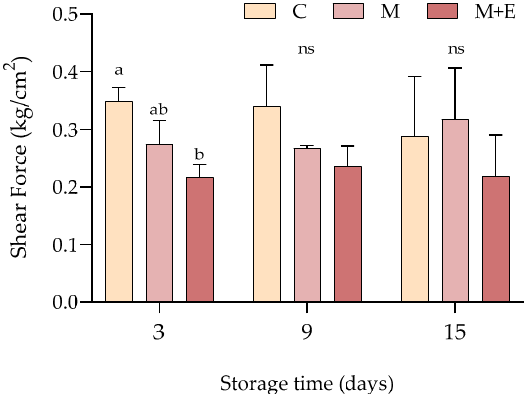
Figure 5. Average shear force values (kg/cm 2 ) of non-marinated (C), marinated (M) and marinated with essential oils (M + E) pork loin slices at 3, 9 and 15 days of refrigerated storage. Data represent means ± SD. a, b = average values lacking a common letter significantly differ among the same sampling time. At the same storage time, ns indicates no significant differences among the samples.